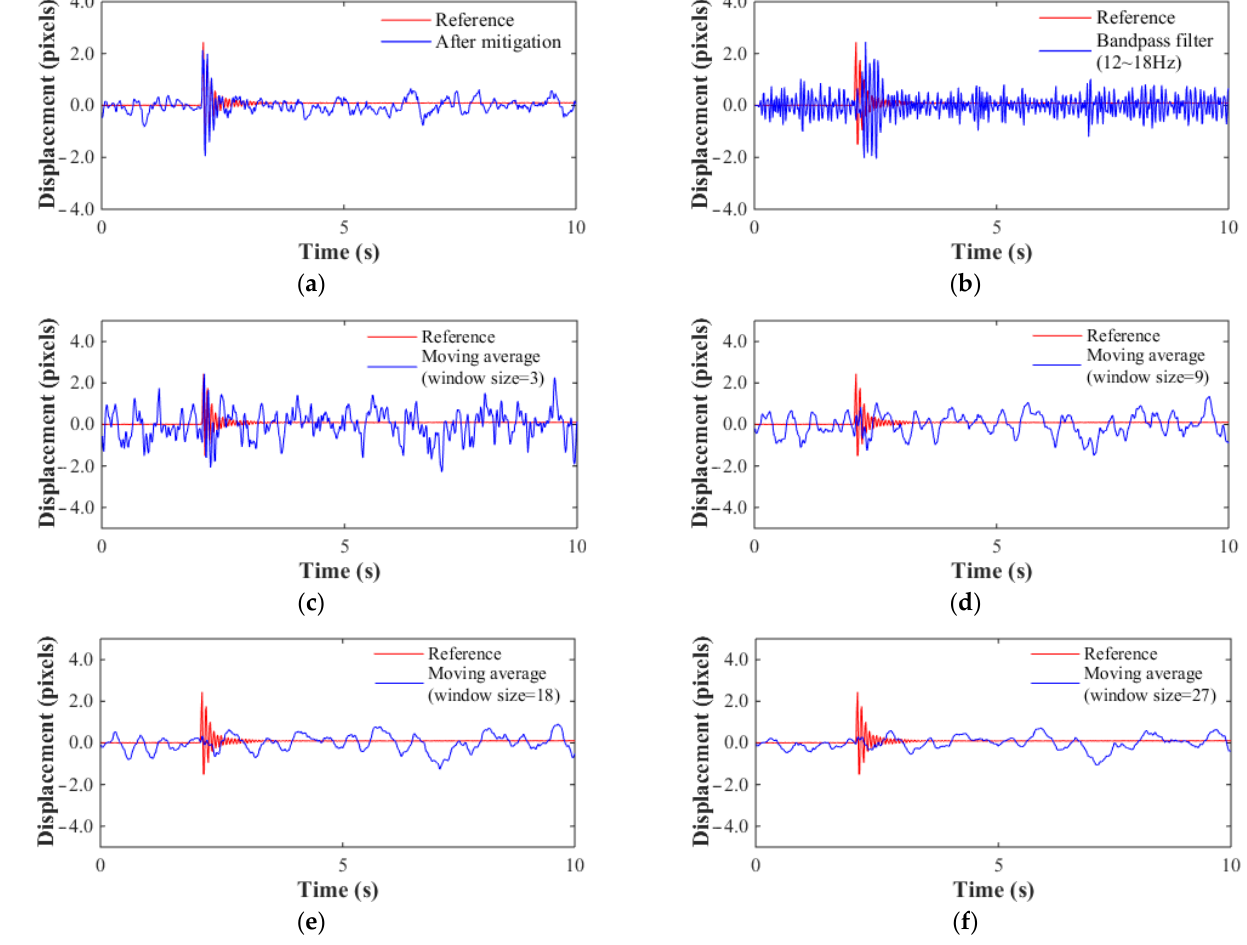
Figure 13. Experimental results, comparison results of the reference camera using ( a ) the proposed method, ( b ) bandpass filter (12~18 Hz), ( c ) moving average (window size = 3), ( d ) moving average (window size = 9), ( e ) moving average (window size = 18), and ( f ) moving average (window size = 27).